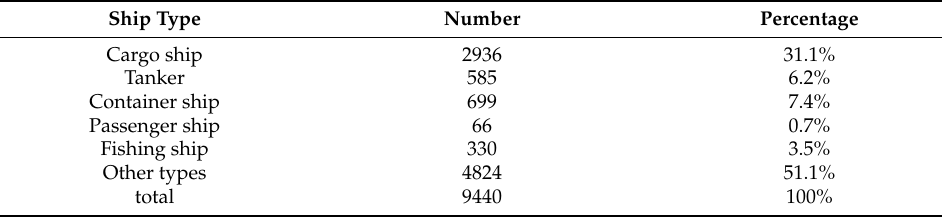
Table 2. Ship types included in the experimental data.